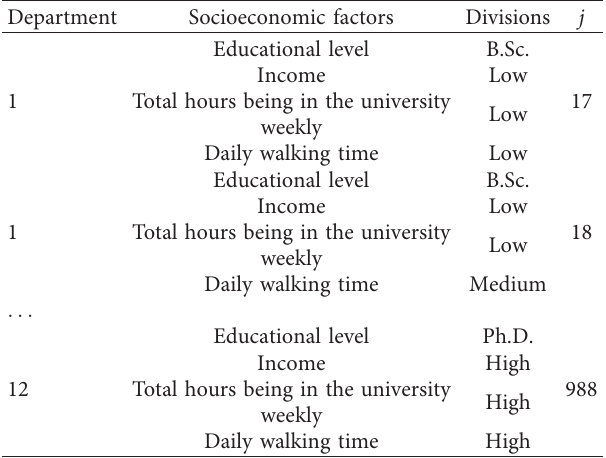
Table 8: Students’ groups in SBUK for parking assignment ( j